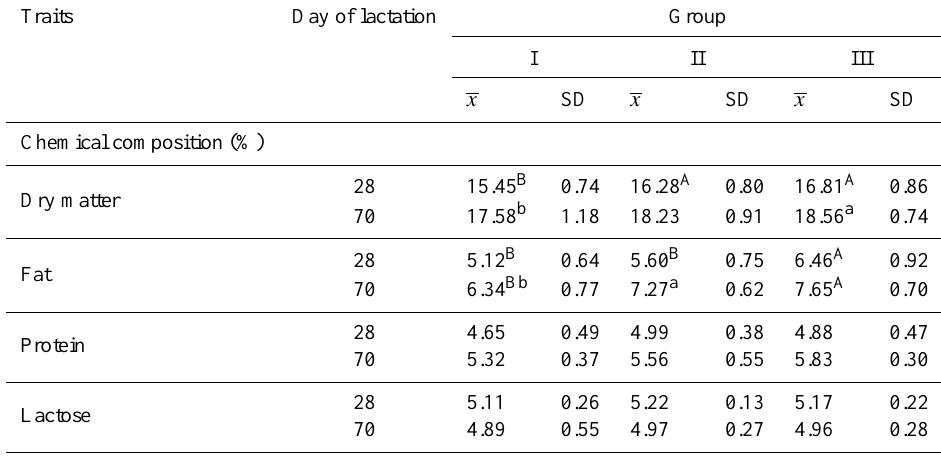
Table 2. Chemical composition of milk. Traits Day of lactation